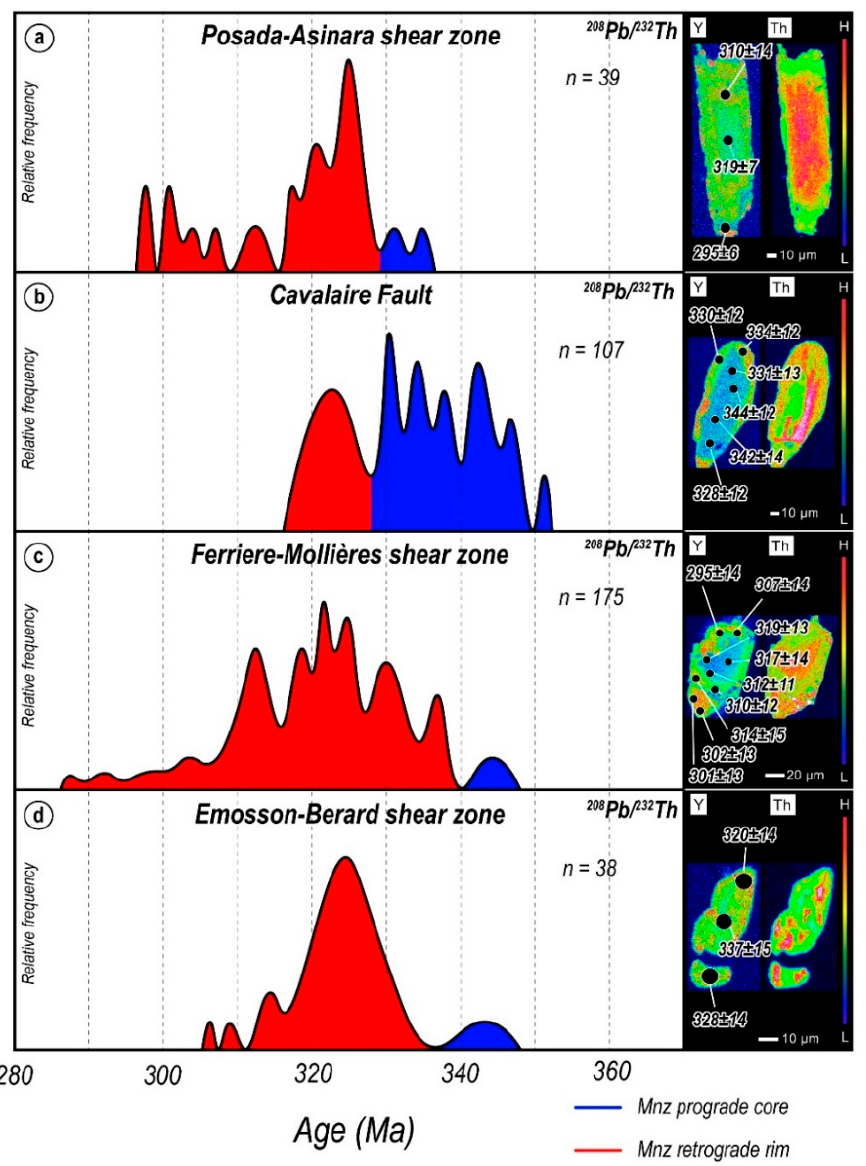
Figure 8. Probability density plot for 208 Pb/ 232 Th ages on monazite obtained from the study branches of the EVSZ. Blue and red fields represent the prograde and retrograde monazite-recorded history, respectively. Representative zoned monazite grains selected for in situ dating with the 208 Pb/ 232 Th relative date with its uncertainties are displayed. The color bar scale qualitatively shows lower (L) to higher (H) Y and Th concentrations. ( a ) Geochronological results from the PASZ (data from Carosi et al., 2020 [67]); ( b ) geochronological results from the CF (data from Simonetti et al., 2020 [62]); ( c ) geochronological results from the FMSZ (data from from Simonetti et al., 2018, 2021